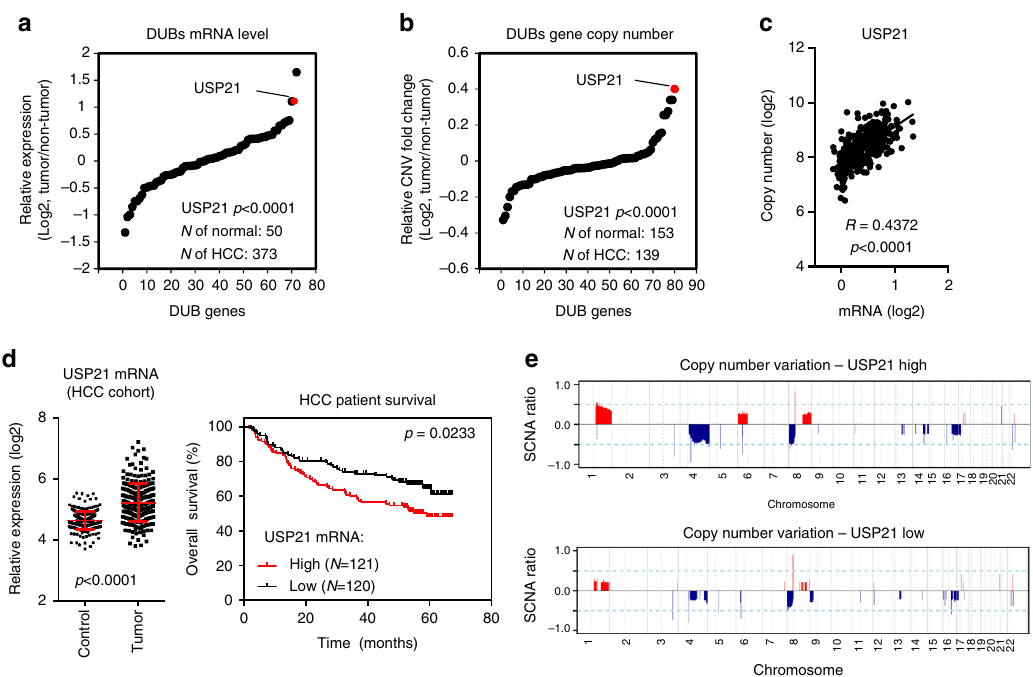
Fig. 4 USP21 is ampli fi ed and correlates with poor survival in HCC. a Relative expression of 72 DUBs in HCC, based on TCGA RNA-sequencing data. Expression was normalized to non-tumor tissue and is expressed as Log2 mean. USP21 is indicated in red . b Relative gene copy number change (mean, Log2) of 80 DUBs in HCC, relative to non-tumor tissue, based on TCGA data. USP21 is indicated in red . c Correlation between copy number variation and USP21 expression change in tumor compared to non-tumor tissue, based on TCGA data from a and b . d USP21 expression correlates with poor survival. Left panel: relative USP21 expression levels in the LCI cohort of 488 patient samples in HCC and non-tumor tissue, based on microarray data from 26 . Right panel: Kaplan-Meier survival analysis of the same patients, separated by USP21 expression. USP21 low re fl ects the bottom 50 percent, USP21 high the top 50 percent of patients. e Frequencies of somatic copy number alteration (SCNAs, Log2) are plotted as a function of genome location for the clinical specimen from d , separated in USP21 high or low groups. Chromosome boundaries and centromere position are indicated by vertical solid and dashed lines , respectively. Horizontal dashed blue lines indicate frequencies of >± 0.5 (Log2). Unless noted otherwise, p values are based on Student ’ s two-tailed t interactors PALB2 and RAD51 (Fig. 2e). Taken together, these fi ndings point to BRCA2 as a target for USP21-mediated deubi- quitination in vivo.